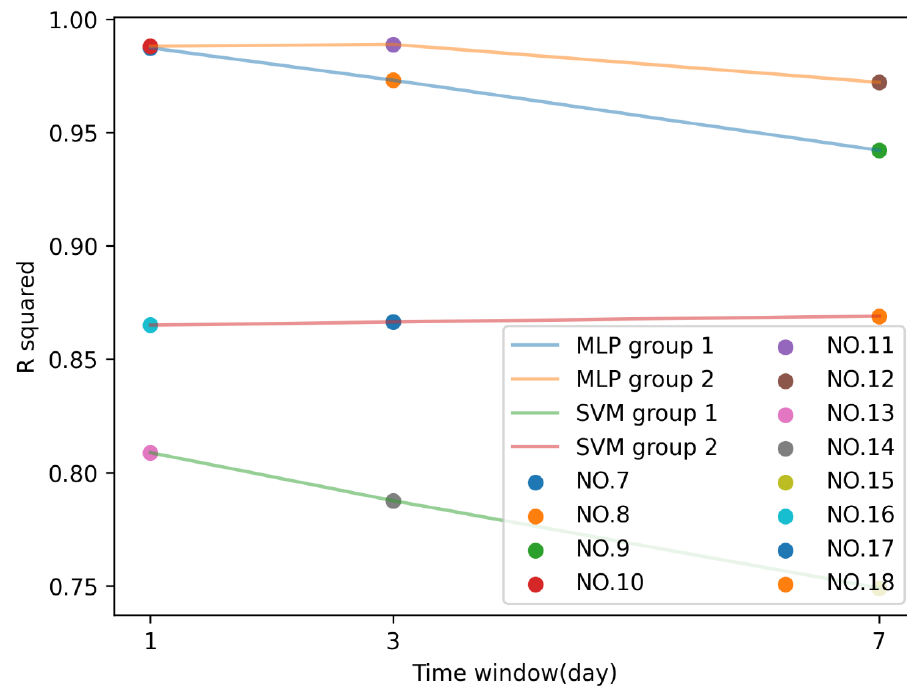
Figure 3. The relationship between the time window and the model R-squared of the MLP and SVM models. The experiment number corresponds to Table 3. The blue line represents the MLP model using spectral variable group 1. The orange line represents the MLP model using spectral variable group 2. The green line represents the SVM model using spectral variable group 1. The pink line represents the SVM model using spectral variable group 2. Group 1 represents the spectral variables that use a single band or band combination. Group 2 represents the spectral variables that use a band combination and band ratio arrangement.